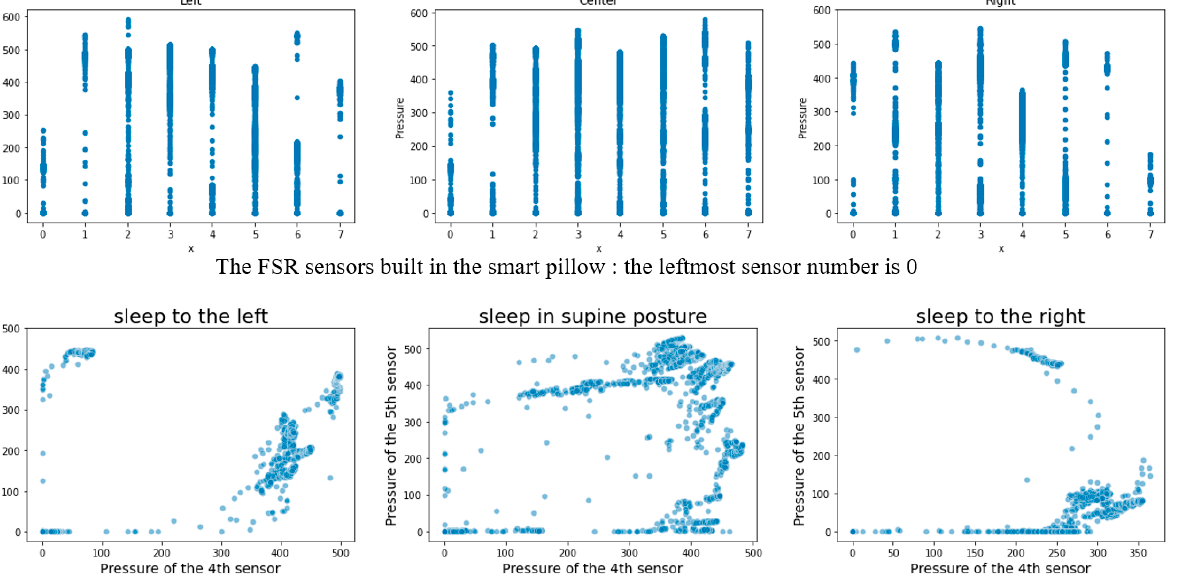
Figure 11. Various pressure distributions for each sleeping posture, each FSR sensor ( above ), and the fourth and the fifth sensors ( below ).